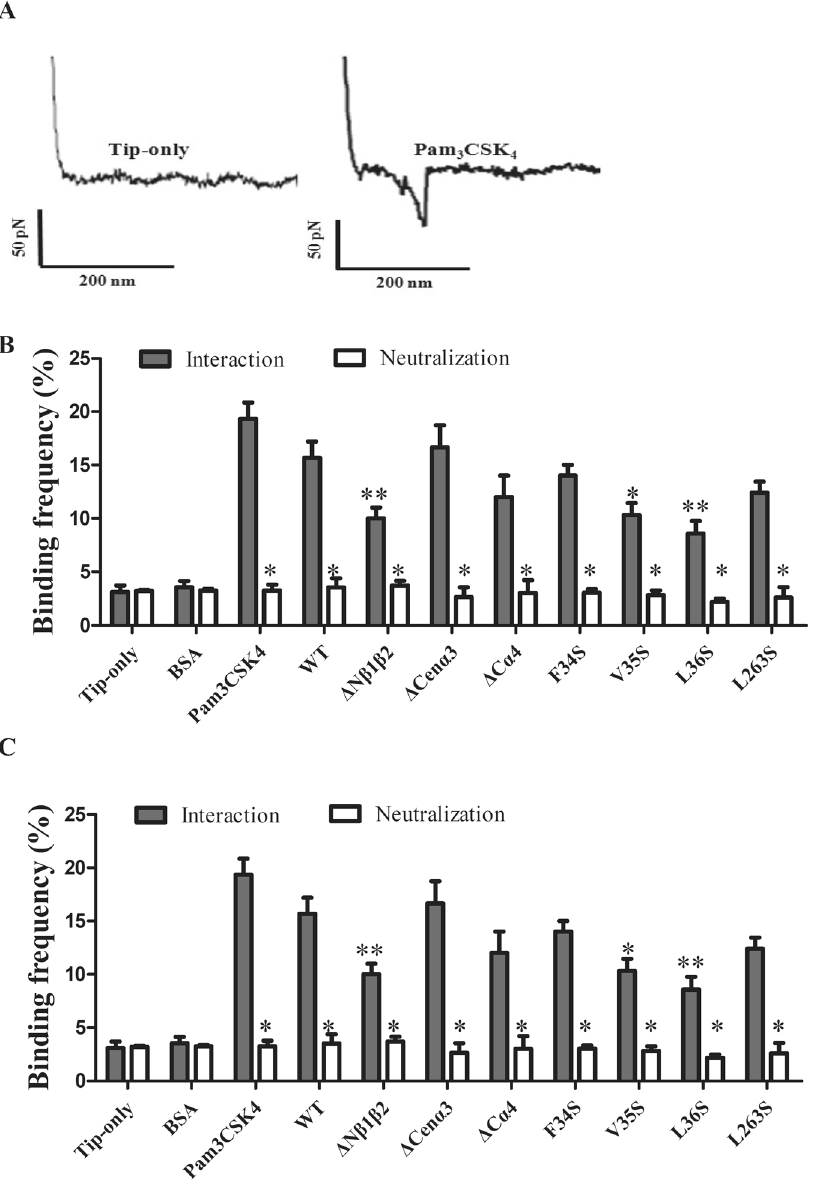
Figure 5. The AFM measurement of the interaction between TLR2 and LipL32 variants. The maximum distribution force was calculated and determined the interaction force between different fragments of LipL32 and TLR2 protein. ( A ) The force-distance curves of AFM measurement. The tip-only (left panel, mock control) and Pam 3 CSK 4 (right panel, positive controls) modified AFM tip were used to analyze the interaction between tip and TLR2 modified mica surface. ( B ) The interaction force between LipL32 variants and TLR2 protein. The different truncated and mutated variants of LipL32 were modified on AFM tip and the interaction forces to TLR2 were therefore measured. The anti-TLR2 antibody was used to neutralize the interaction between LipL32 and TLR2 and the interaction forces were calculated. ( C ) The binding frequency between LipL32 truncated and mutated variants and TLR2 protein. The binding frequency was calculated from the interaction of different LipL32 variants and TLR2 protein. The anti-TLR2 antibody was used to neutralize the interaction between LipL32 and TLR2 and the binding frequency were calculated. Gray bars, LipL32-TLR2 interaction; white bars, anti-TLR2 antibody neutralization. * p < 0.05; ** p < 0.01; *** p <